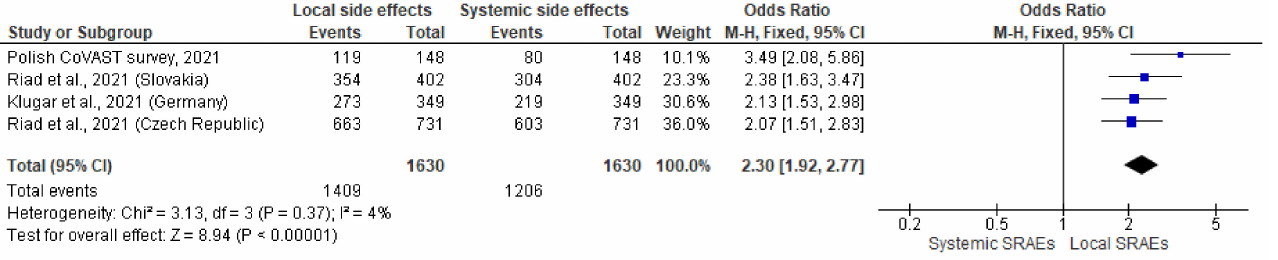
Figure 5. Forest plot of gender-specific pooled analysis of local and systemic adverse effects (mRNA vaccine) in four European countries (females